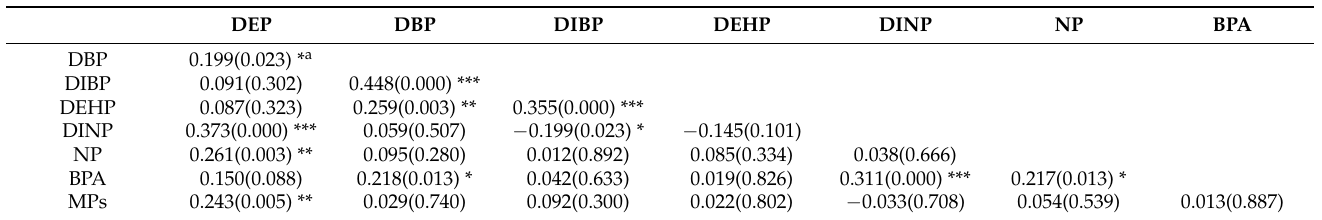
Table 4. Odds ratios (OR) and 95% confidence intervals (CI) of DEP in fish among river estuary and fish habitat. River Estuary DEP FS LJ